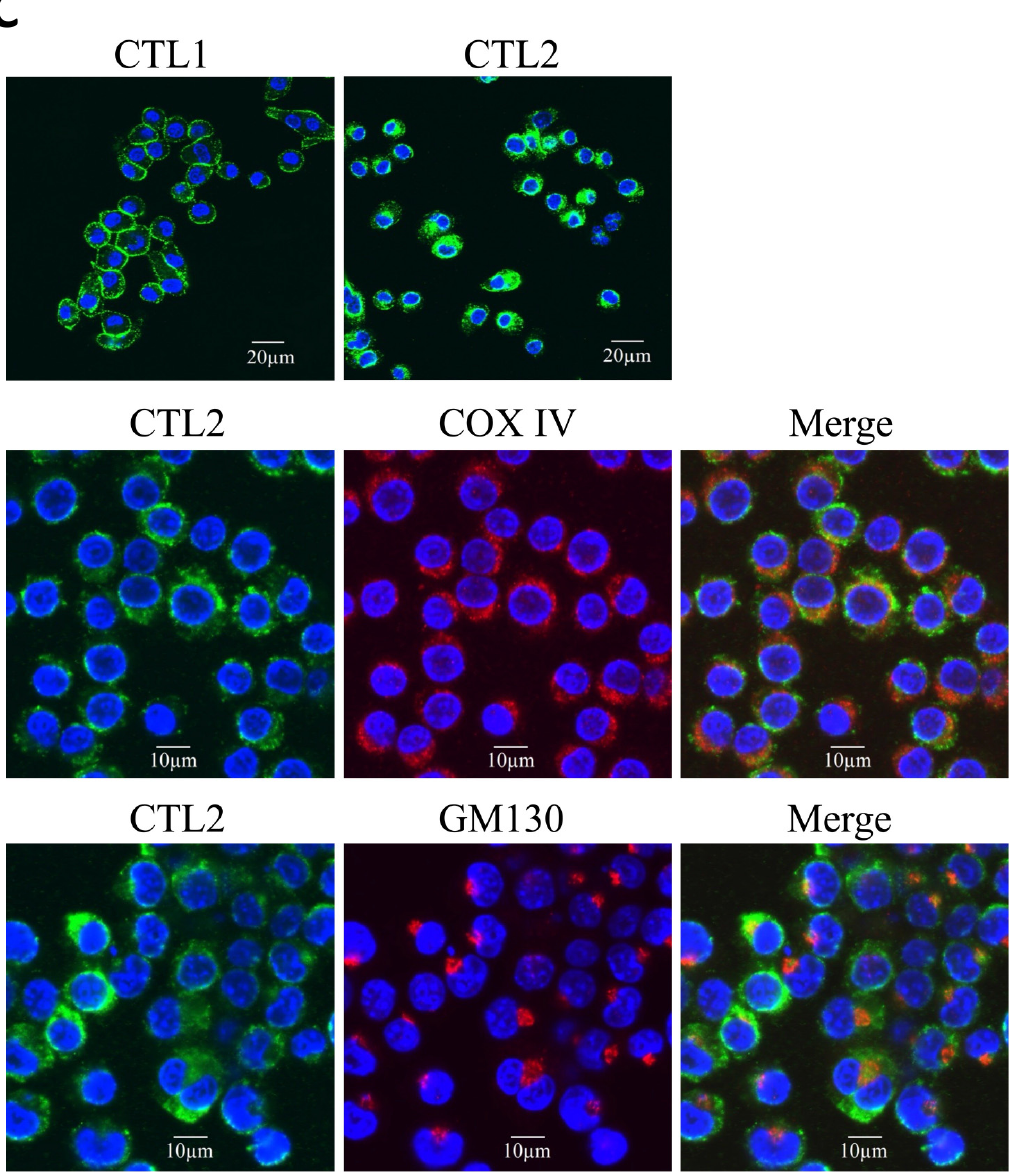
Figure 1. Expression of choline transporters in SIM-A9 cells. ( A ) Expression of the mRNA of choline transporters CHT1, CTL1-5, and OCT1-2. Real-time PCR was used to analyze the mRNA expression of choline transporters, and the results are expressed as the ratio of target mRNA to β -actin mRNA. Data are shown as the mean ± SD ( n = 3). BLQ, below the limit of quantification. ( B ) Detection of CTL1 and CTL2 proteins by Western blot analysis. ( C ) Subcellular distribution of CTL1 and CTL2 proteins was analyzed by immunocytochemistry followed by confocal microscopy. CTL1 and CTL2 are shown in green, and MG130 and COV IV in red. Nuclei were stained with DAPI (blue). Merged images indicate